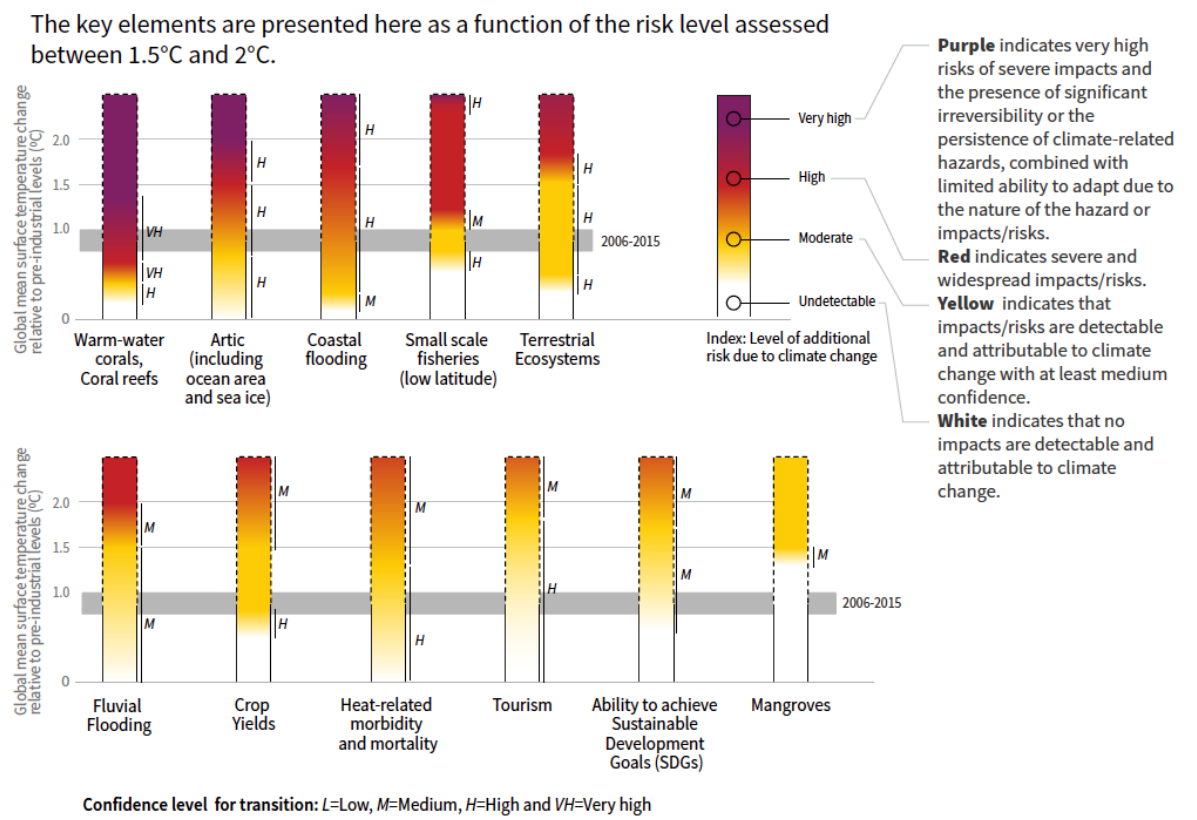
Figure 7. The dependence of risks and/or impacts associated with selected elements of human and natural systems on the level of climate change, highlighting the nature of this dependence between 0°C and 2°C warming above pre-industrial level (from Hoegh-Guldberg et al.,